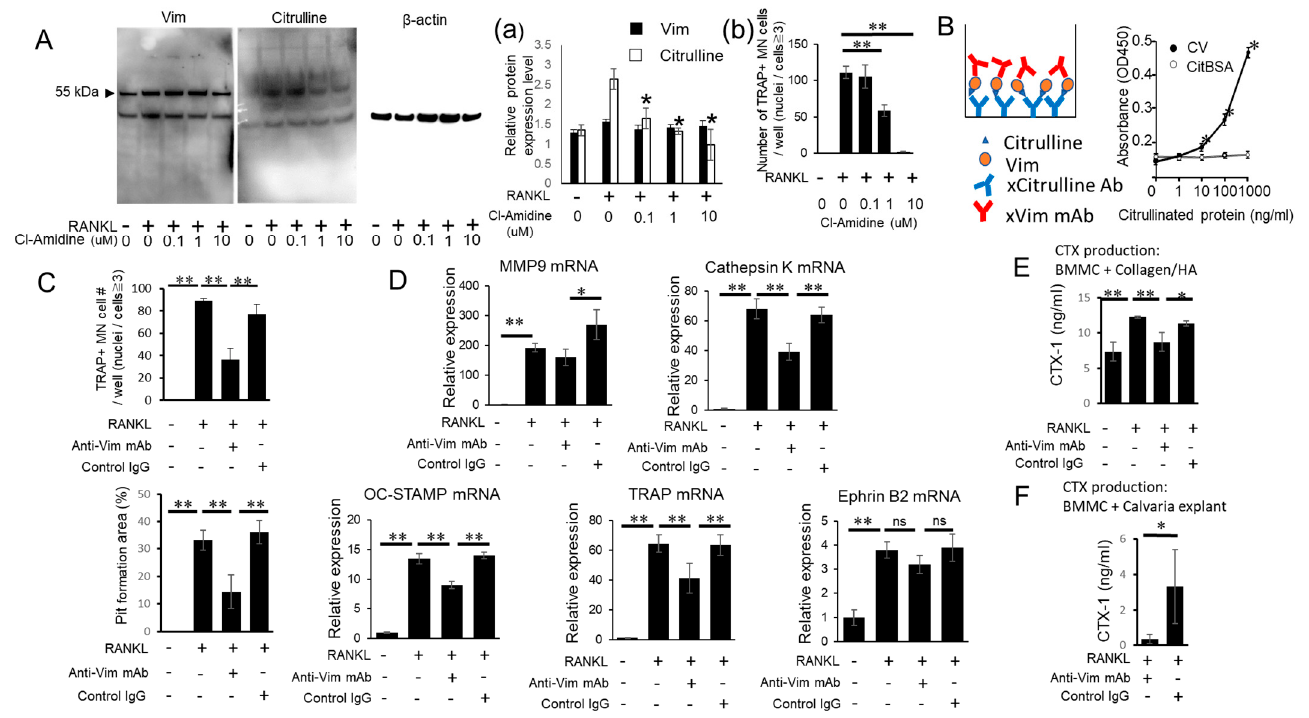
Figure 2 . Possible engagement of Cl-amidine-sensitive PAD in the citrullination of vimentin and anti-vimentin mAb-mediated interruption of CV-induced OC-genesis. ( A ) OC precursors were stimulated with or without RANKL (50 ng/mL) and/or Cl-amidine. After 24 h, supernatant and cell lysates were collected and vimentin (Vim) or citrulline was detected by Western blotting using the antibodies described in the Materials and Methods section. Protein bands were measured by densitometry to determine the levels of Vim, citrulline and β -actin and relative expression of Vim and citrulline was calculated in comparison with an internal control of β -actin (Figure 2(Aa)). After 6 days of above-noted OC-genesis conditions, TRAP staining was performed (Figure 2(Ab)). ( B ) Sandwich ELISA to determine citrullination of Vim. Anti-citrulline antibody was used as a capture antibody and anti-Vim antibody as a detection antibody. Different concentrations of CV and citrullinated BSA (CitBSA) (0, 1, 10, 100 and 1000 ng/mL) were used as a sample. ( C , D ) OC precursors were stimulated with RANKL in the presence or absence of anti-Vim mAb or control IgG for 48 h or 7 days with the addition of fresh medium every 3 days. TRAP staining, pit formation assays and qPCR were performed. ( E , F ) OC precursors were cultured on a type I collagen-treated hydroxyapatite coating plate ( E ) or on murine calvaria bone disks ( F ). After 7 days, the supernatant was applied to CTX-1 ELISA. All in vitro assays were performed in triplicate and the results were expressed as the mean ± SD. All experiments were independently repeated three times. * p < 0.05; ** p < 0.01. #: number